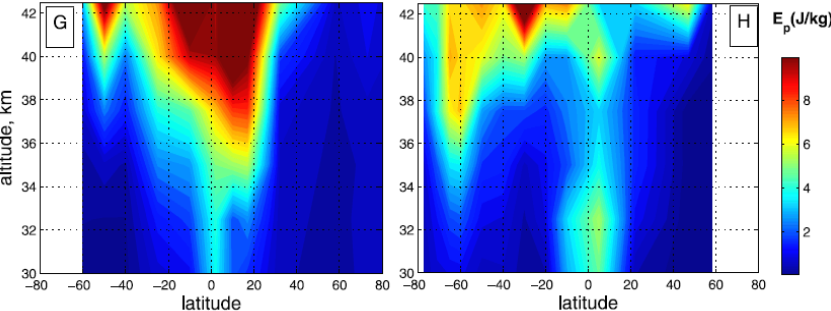
Fig. 54. Zonal mean values of the potential energy E p (Joule/kg) of gravity waves as determined from GOMOS scintillation measurements during two 4 months periods of year 2003: January-March plus December (left), and June-September (right). See text for discussion (from Sofieva et al., 2009).